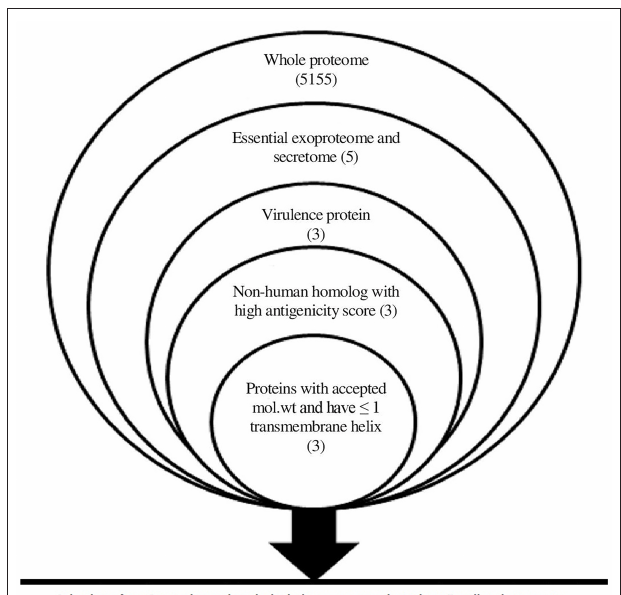
FIGURE 2 | A chart summarizing applied filtration steps for the nomination of potential vaccine candidates by applying in silico reverse vaccinology